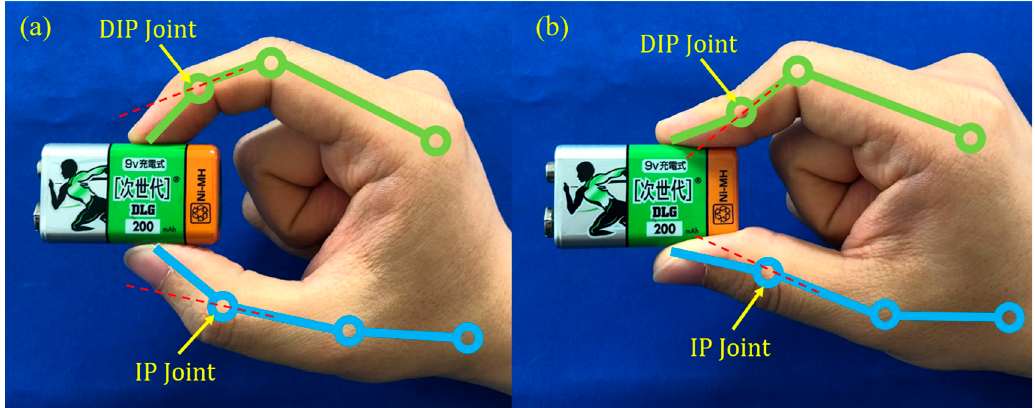
Figure 11. Hyperextension of fingertip: ( a ) grasping without hyperextension; ( b ) grasping with hyperextension.